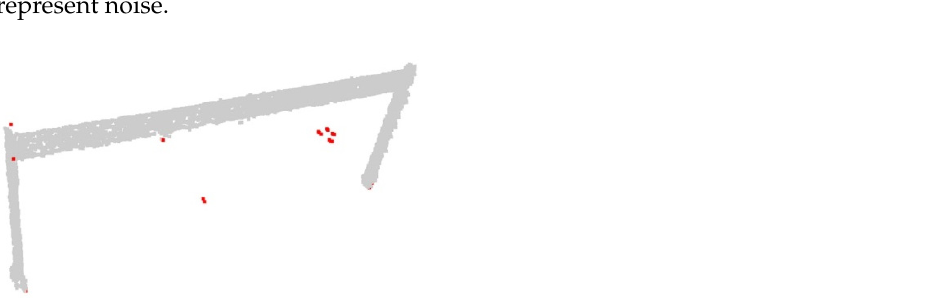
Figure 5. Cloth Simulation Filter (CSF) ground filtration examples: ( a ) an example of the source cloud, ( b ) the same object after ground filtration colored by classes—ground and non-ground, ( c ) an example of ground filtration for a point cloud with TLS, ( d ) the final segment of the point cloud passed to the next stage of the algorithm . In addition to filtering out ground points, it was also necessary to filter out points that were noise and did not belong to the object of interest. First, “isolated points” noise filtering was applied using Open3D library functions. These methods examine the neigh- borhood in the point cloud and reject outliers on this basis. Two methods were used: